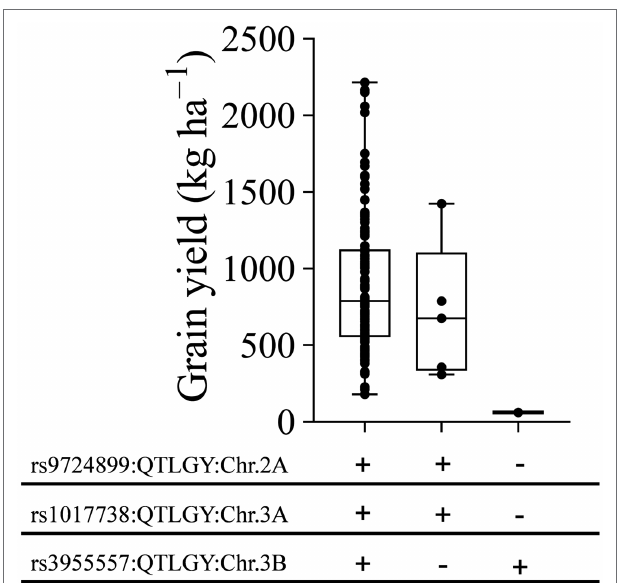
FIGURE 8 | Effect of different allele combinations of significant marker-trait associations on grain yield performance at Wad Medani under late sowing date. The MDLs were divided into three classes based on haplotype diversity analysis for three significant MTAs. Black circles indicate average grain yield by each genotype. “+” marks indicate positive alleles, “–” marks indicate negative alleles. rs9724899, rs1017738, and rs3955557 denote significant MTAs for grain yield on chromosomes 2A, 3A, and 3B,